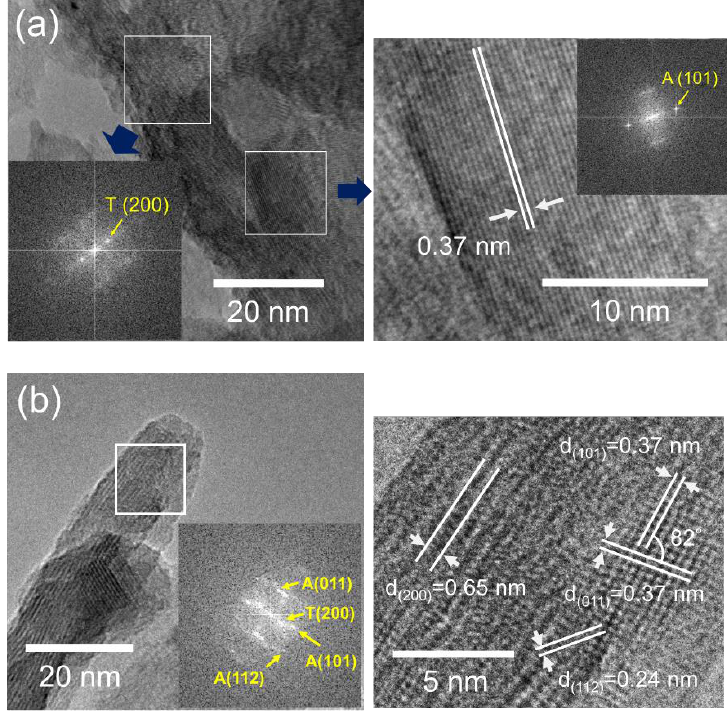
Figure 6. TEM images and fast Fourier transform (FFT) diffraction patterns (T = Titanate, A = Anatase) of annealed PTNT at ( a ) 400 and ( b ) 500 °C for 1 h, respectively.